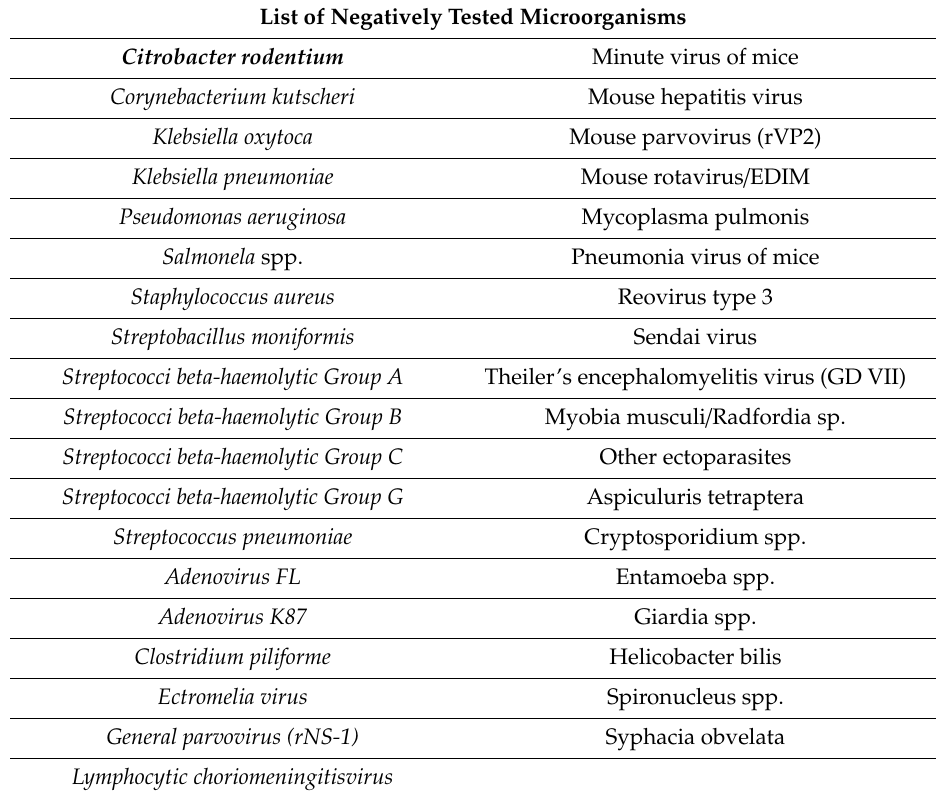
Table A2. Number of mouse samples for plasma and RT-qPCR gene expression analysis.